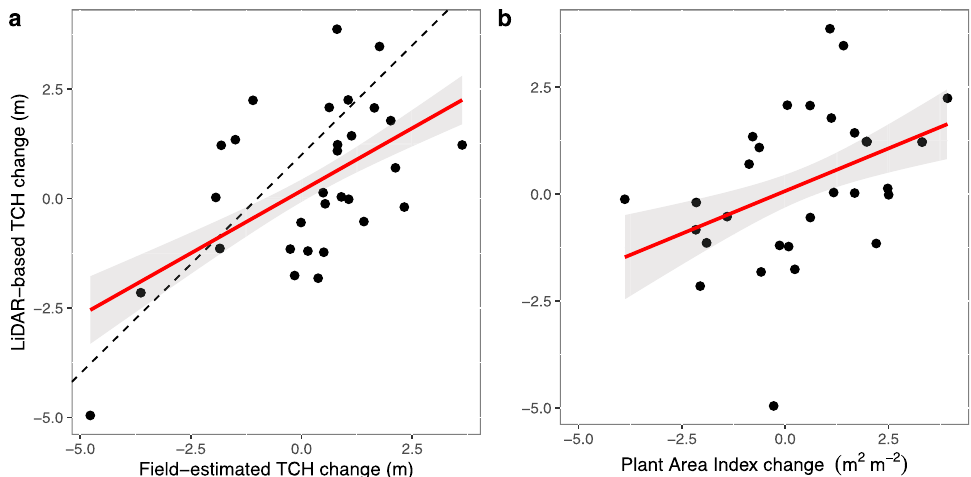
Fig. 3 Correlation between LiDAR-derived and fi eld-estimated change in canopy structure during the 2016 – 2015 ENSO event. LiDAR-based top-of- canopy height (TCH) change (m) versus a fi eld-estimated TCH change (m) and b plant area index (PAI) change (m 2 m − 2 ) between November 2014 and February 2017 from 38 permanent forest inventory plots (SAFE plots, each 25 × 25 m in size). Black dots represent the permanent plots (and missing plots are due to the presence of clouds during the fi rst and/or second fl ights). The red lines represent values predicted by multiple linear regression, with the shaded grey area depicting the 95% con fi dence intervals.